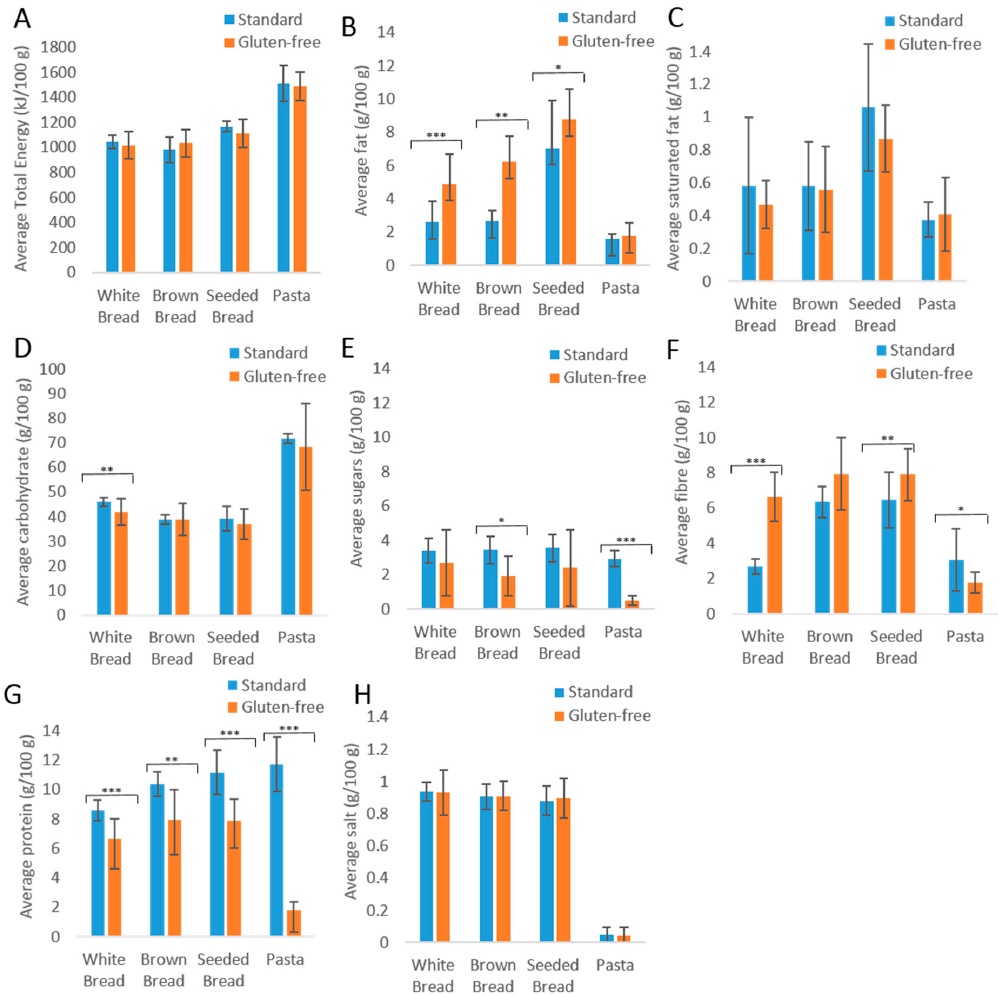
Figure 4. The average nutritional values of standard and gluten-free products for ( A ) total energy; ( B ) fat; ( C ) saturated fat; ( D ) carbohydrate; ( E ) sugars; ( F ) fiber; ( G ) protein; ( H ) salt. Key: * = p < 0.05, ** = p < 0.01, *** = p < 0.001.